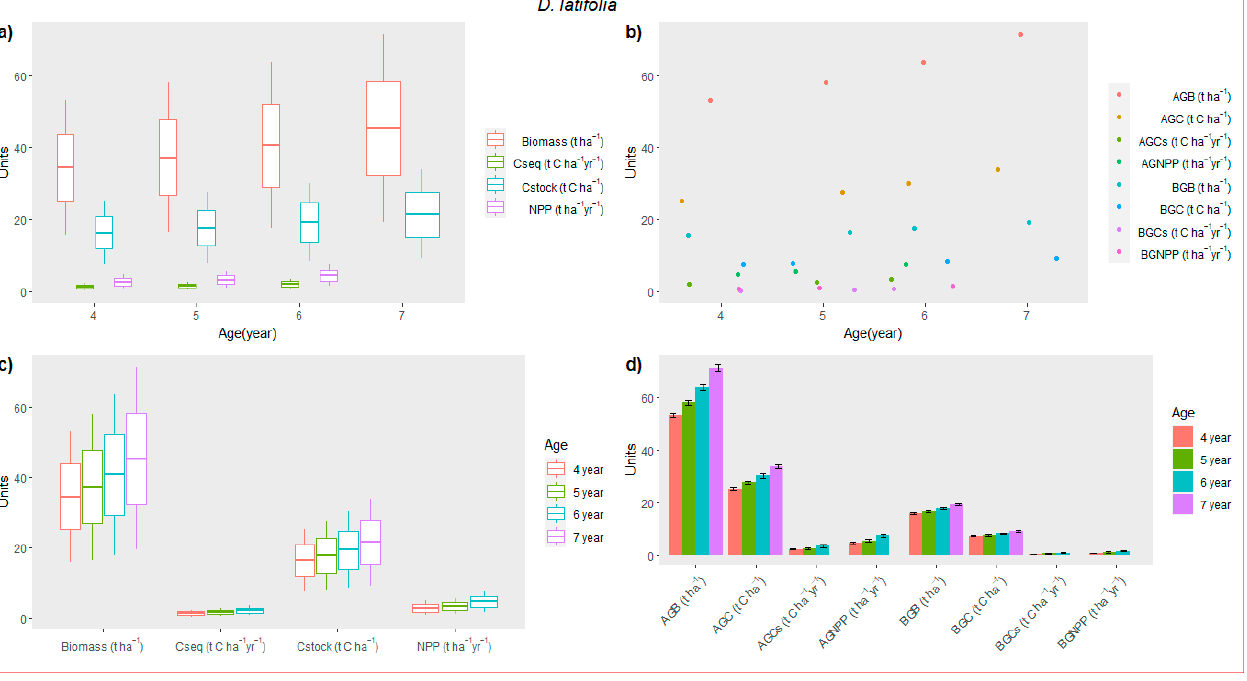
Figure 6. Relationship between tree stand characteristics and age of the stand ( D. latifolia ).